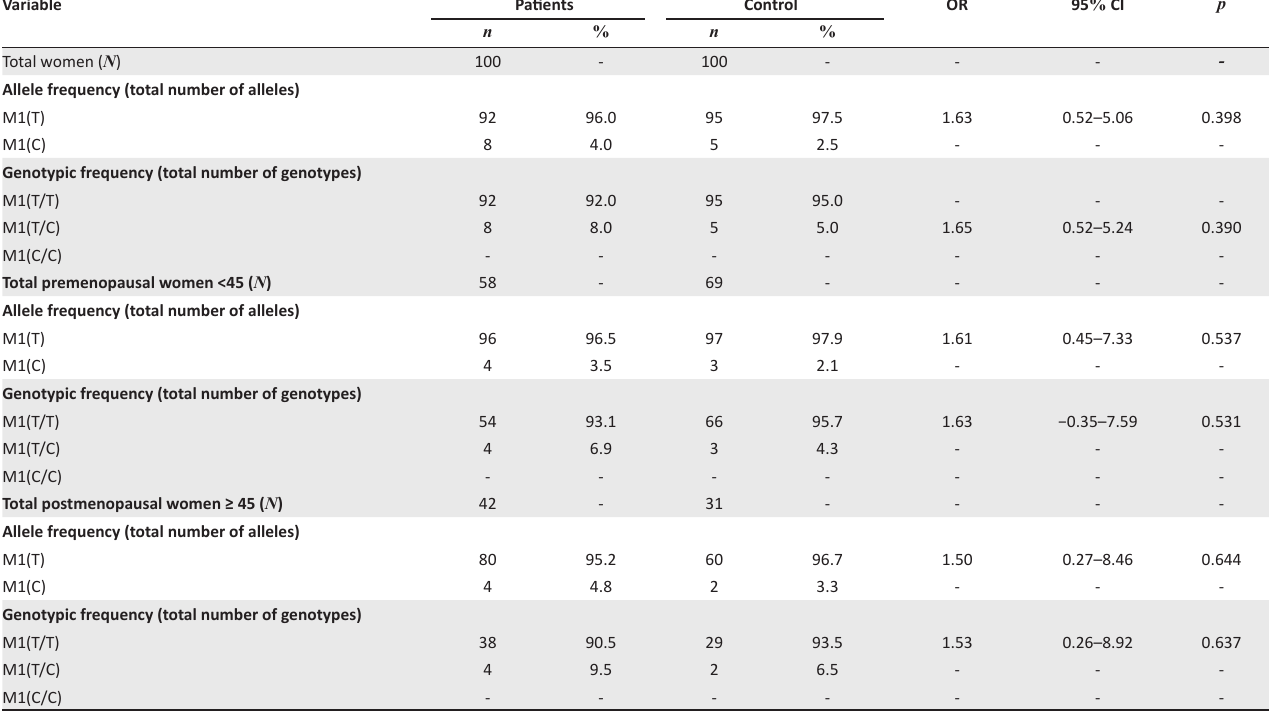
TABLE 2: Allelic and Genotypic frequencies of Cytochrome P-4501A1 M1 allele for Sudanese female breast cancer patients and control group with menopausal ages.